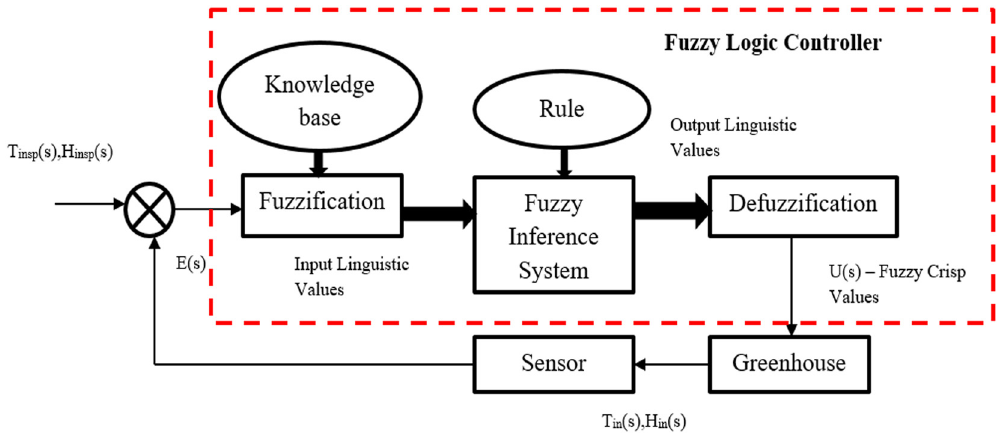
Figure 13: Schematic for an upgraded greenhouse using fuzzy logic controllers ( Subin et al. 2020